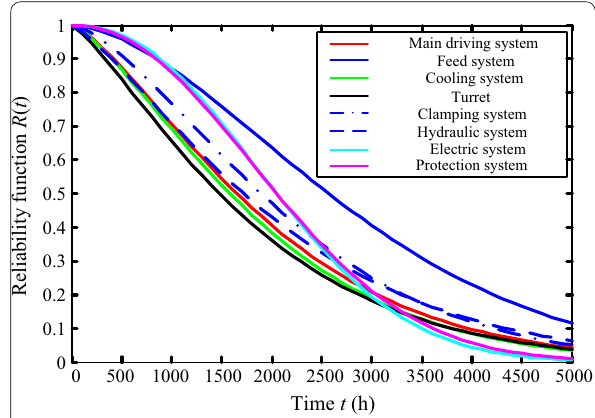
Figure 2 Changing curve of reliability of subsystems along with time